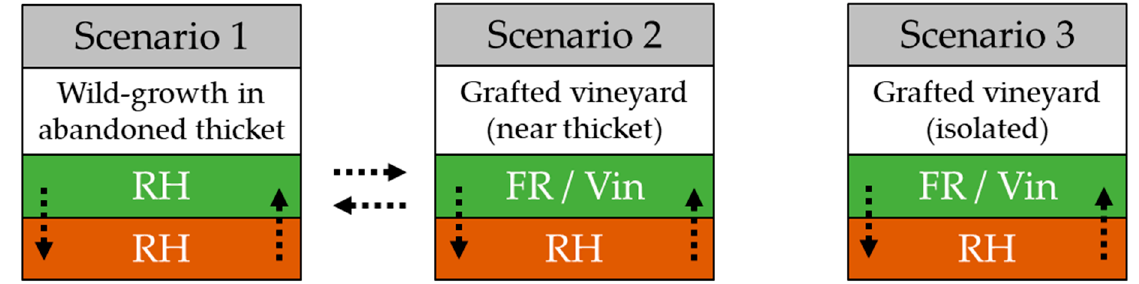
Figure 1. Possible phylloxera populations scenarios in commercial vineyards on leaves (green) and roots (brown) of rootstock hybrids (RH), V. vinifera (Vin), and fungus-resistant varieties (FR). Dashed arrows represent potential annual migration pathways of phylloxera larvae.